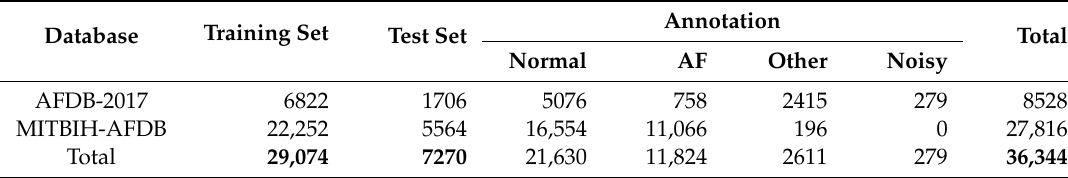
Table 4. Annotations for the two ECG